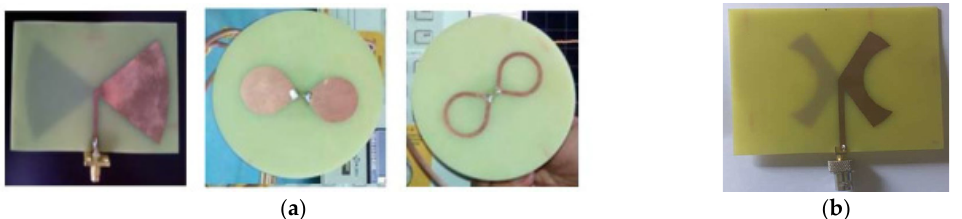
Figure 21. ( a ) A series of double ‐ layer bowtie antennas with edge and middle sliced modifications a top view studied in [130], and ( b ) The double ‐ layer bowtie antenna studied in [129]. e) Aperture Antennas